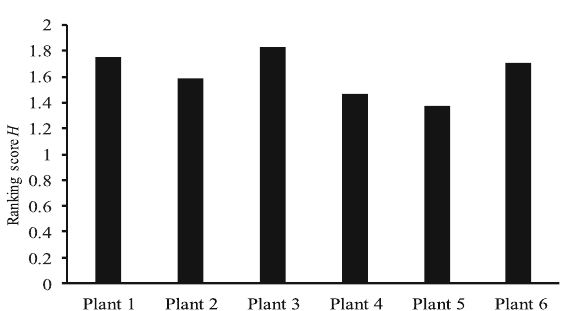
Fig. 6 The ranking results produced by the RankBoost method